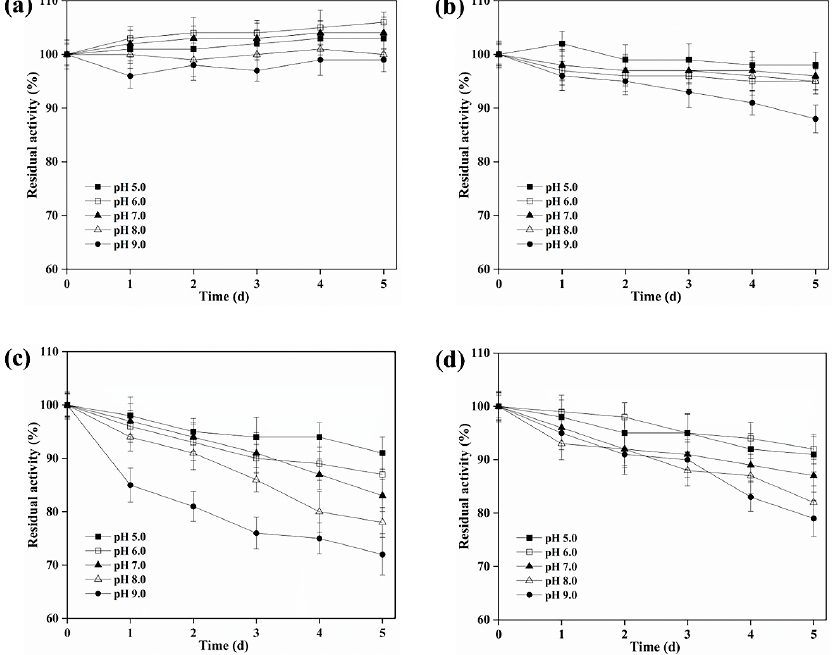
Figure 3. The pH stability of recombinant TGs. The effect of pH on the stability of ( a ) BAMTG, ( b ) BCETG, ( c ) BSATG, and ( d ) BARTG. Three independent experiments were performed to calculate the values described by means ± SD.